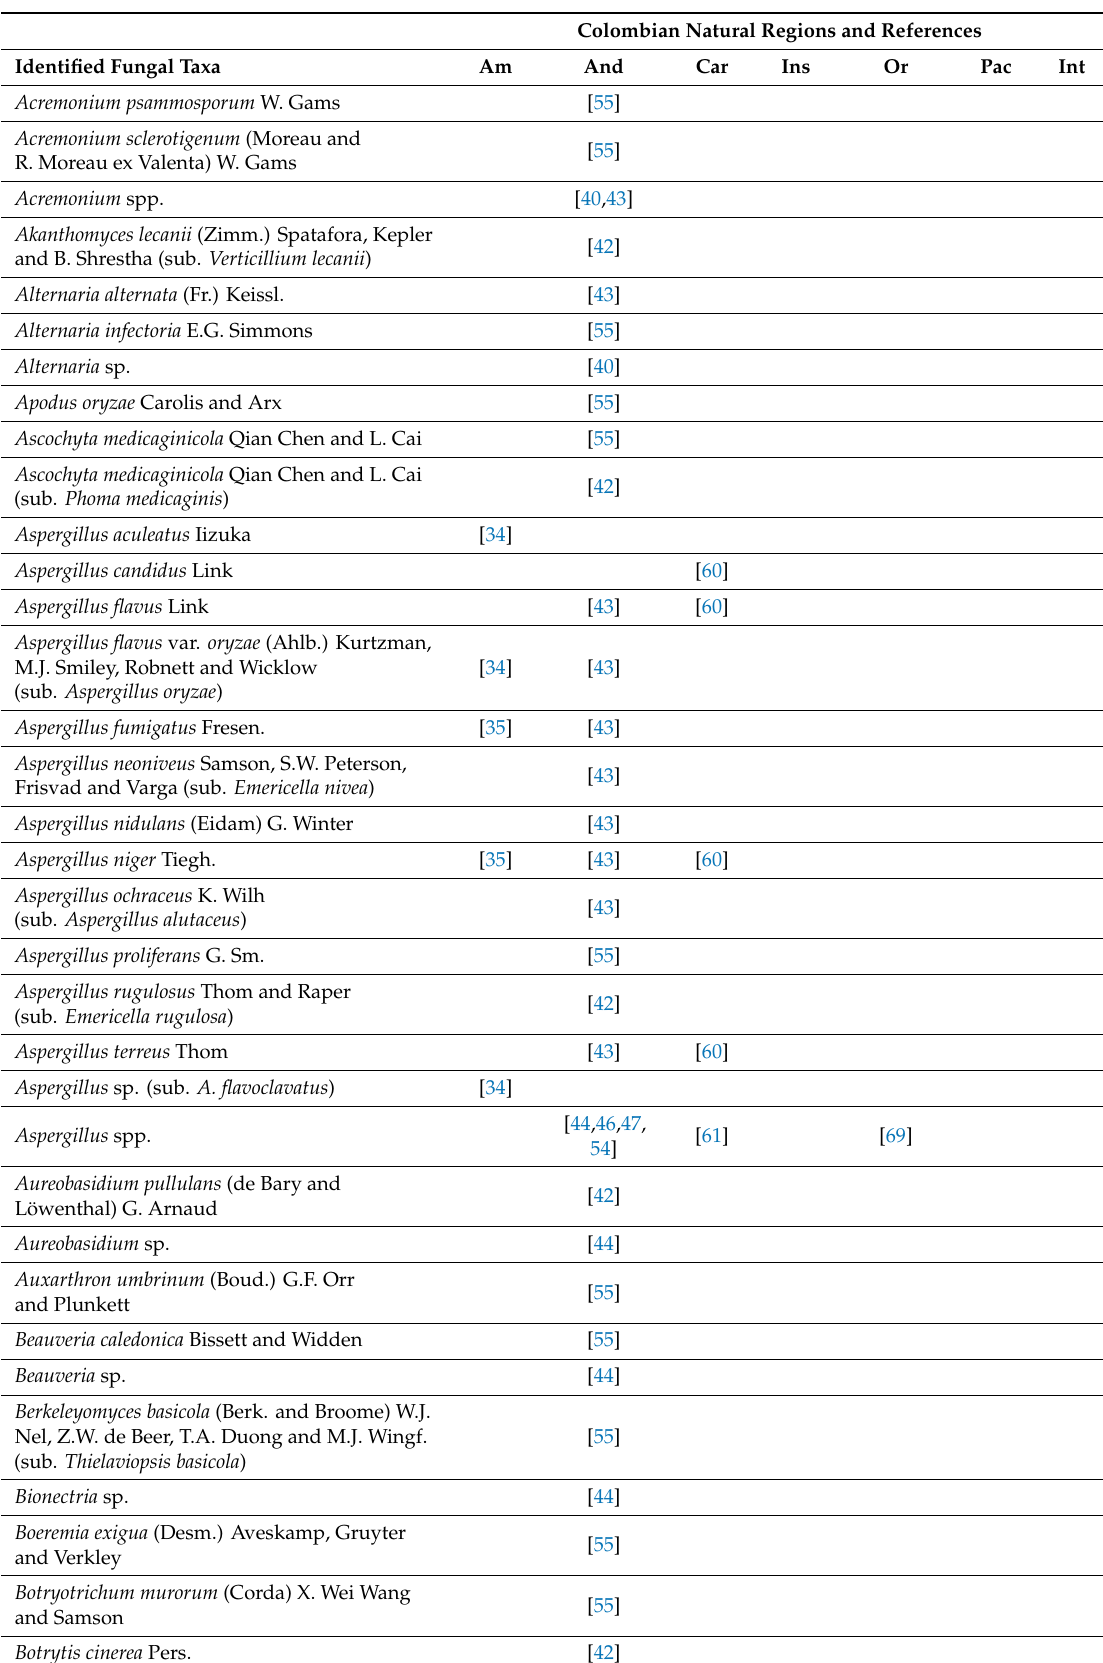
Table 1. Cont . Colombian Natural Regions and